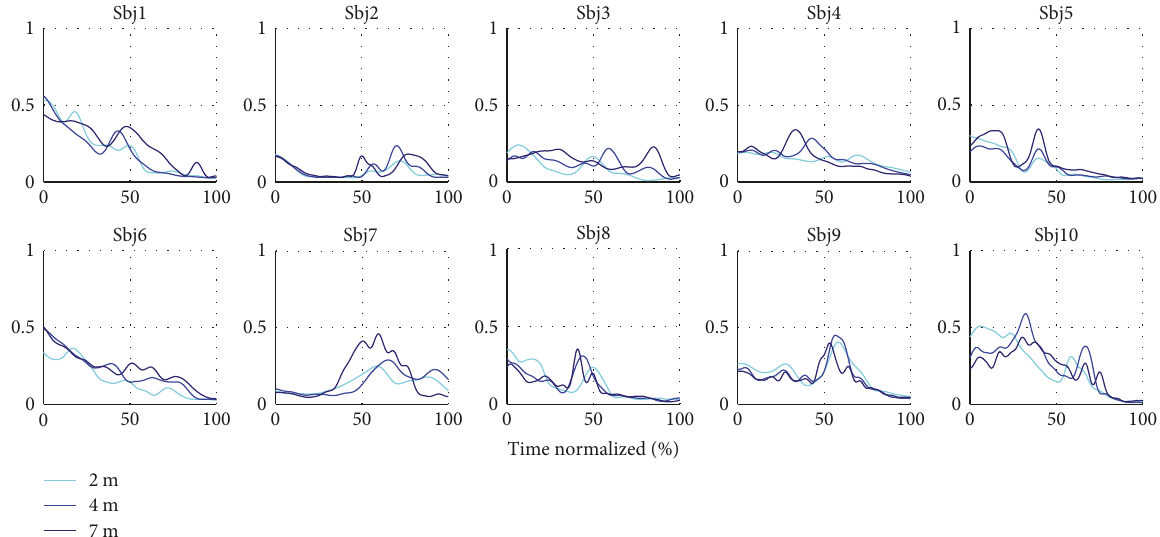
Figure 15: Average combination coe ffi cient c